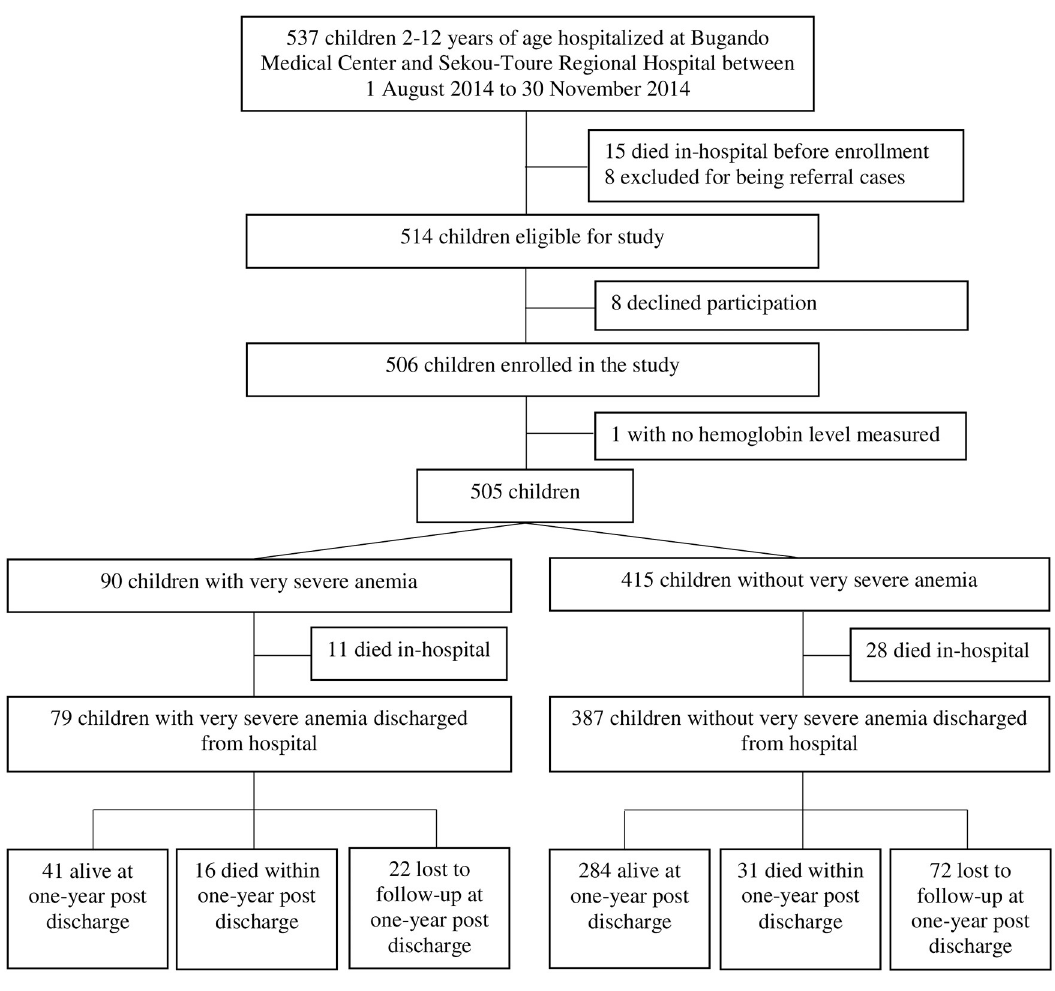
Fig 1. Flow diagram of study participants from hospitalization to one-year post discharge